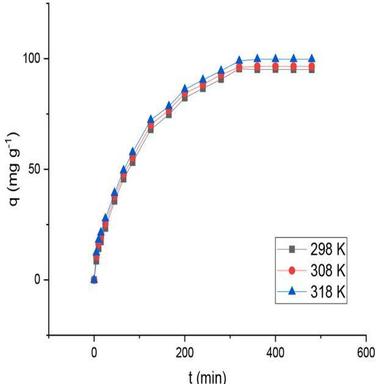
The influence of contact time on the adsorption of MB on Perlite@GO.